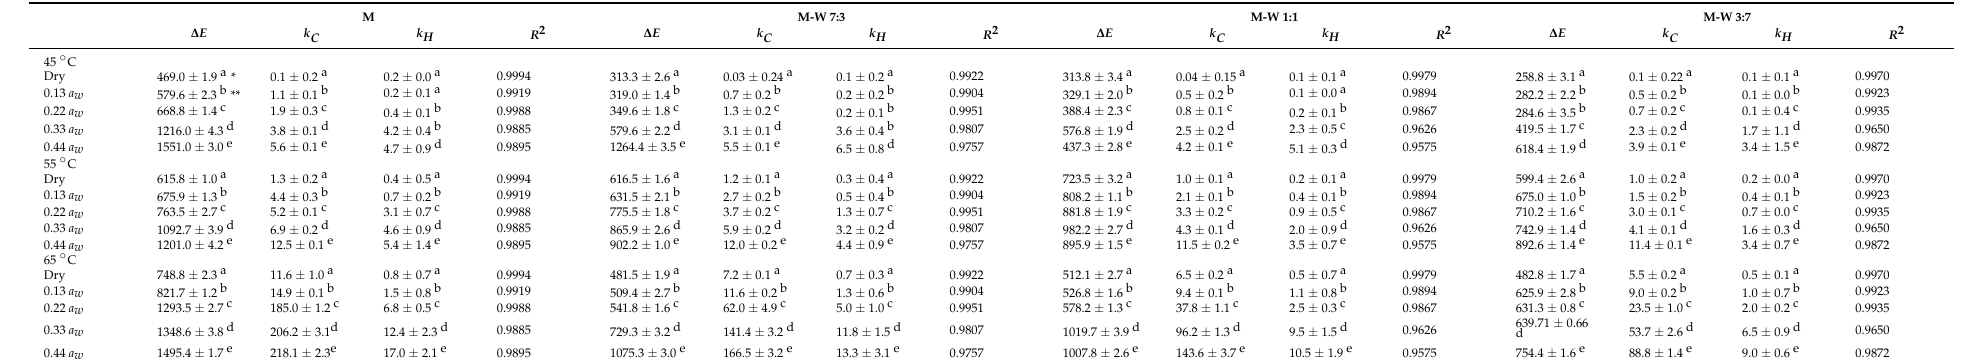
Table 2. The rate of color changes ( k C , day − 1 ), color difference ( ∆ E ), the rate of 5-HMF accumulations ( k H , day − 1 ), and R 2 of zero-order reaction for the amorphous pure amorphous maltose (M) and maltose/WPI (M-W) mixtures at the studied conditions (dry state~0.44 a w and 45~65 ◦